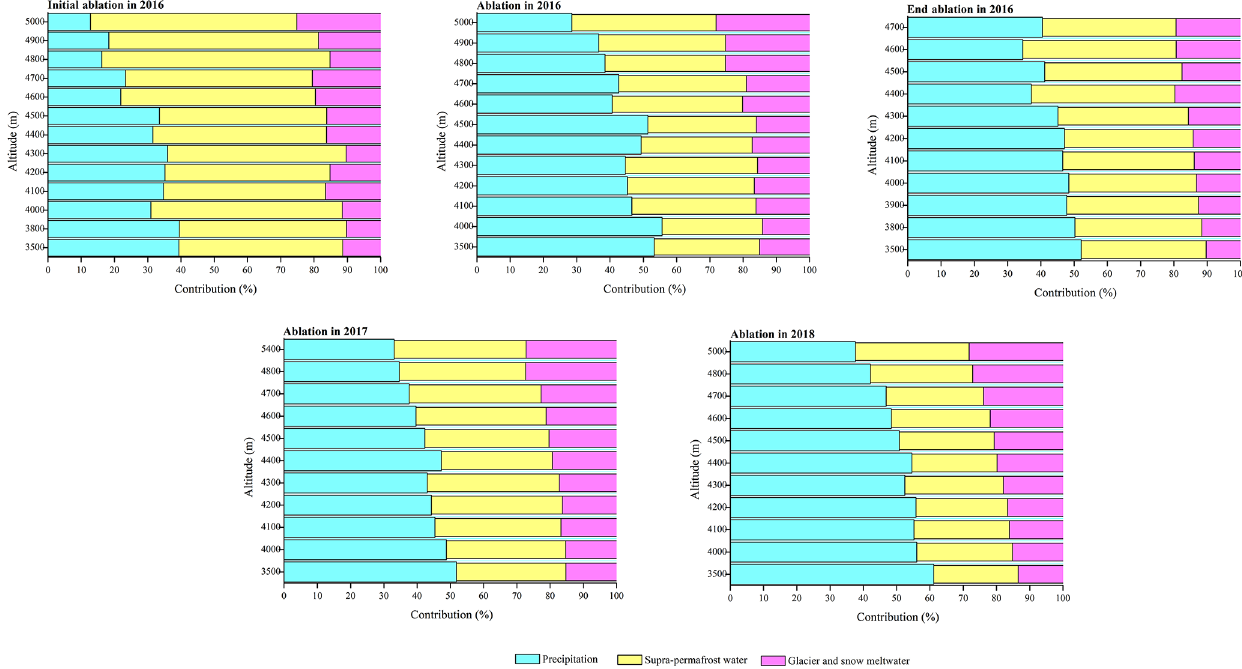
Figure 9. Recharge proportion from possible sources to river water at different altitudes during different ablation in 2016 and ablation from 2016 to